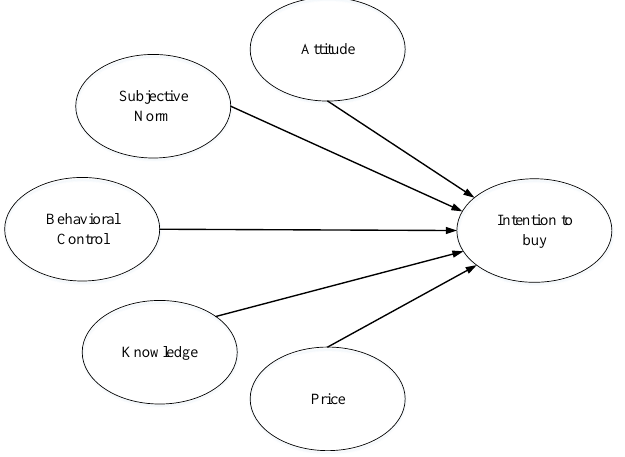
Fig. 1. Conceptual framework of this